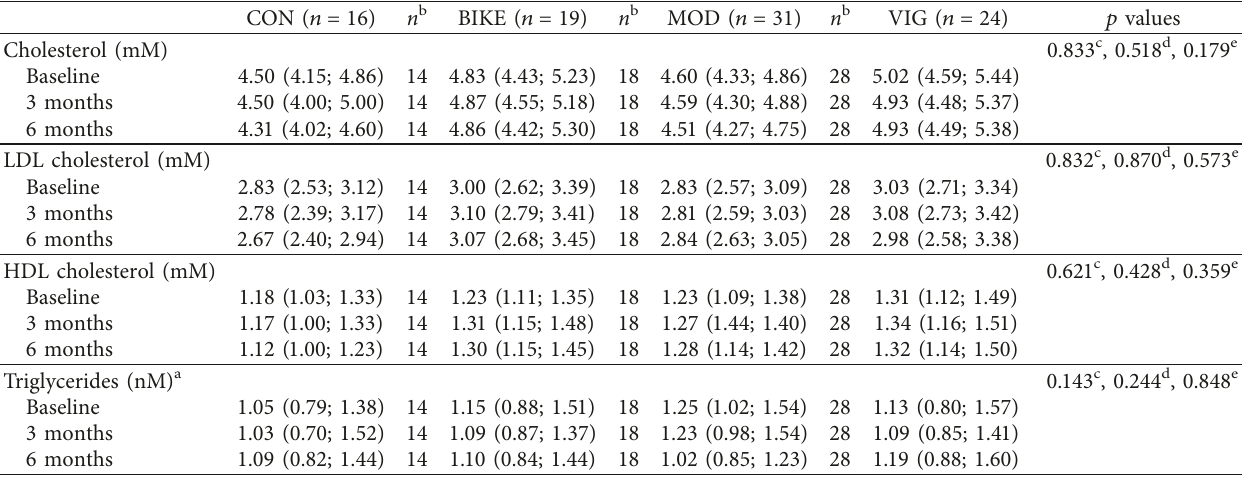
Table 2: Concentrations of blood lipids at baseline and at 3 and 6